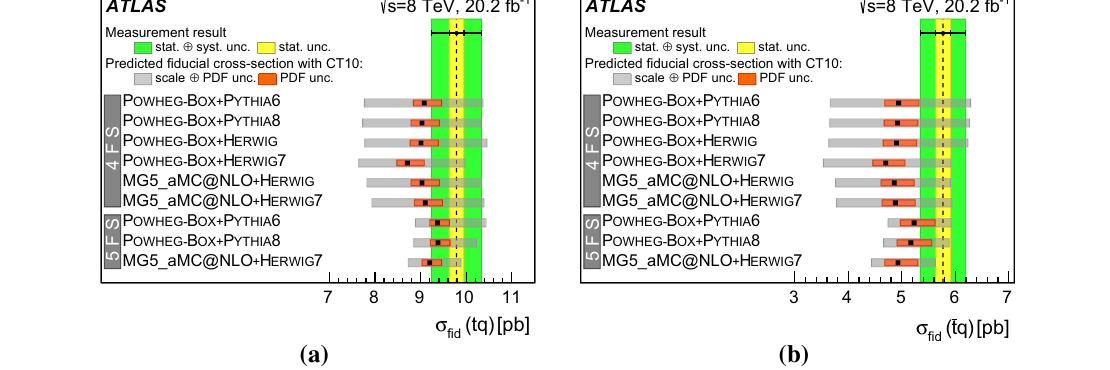
with different parton-shower models. The uncertainties in the predic- tions include the uncertainty due to the scale choice using the method of independent restricted scale variations and the intra-PDF uncertainty in the CT10 PDF